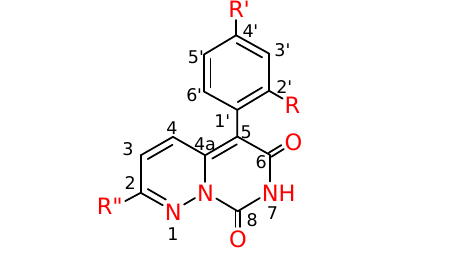
Figure 4 . Numbering system for compounds 4a-f, 4f ′ , 4g ′